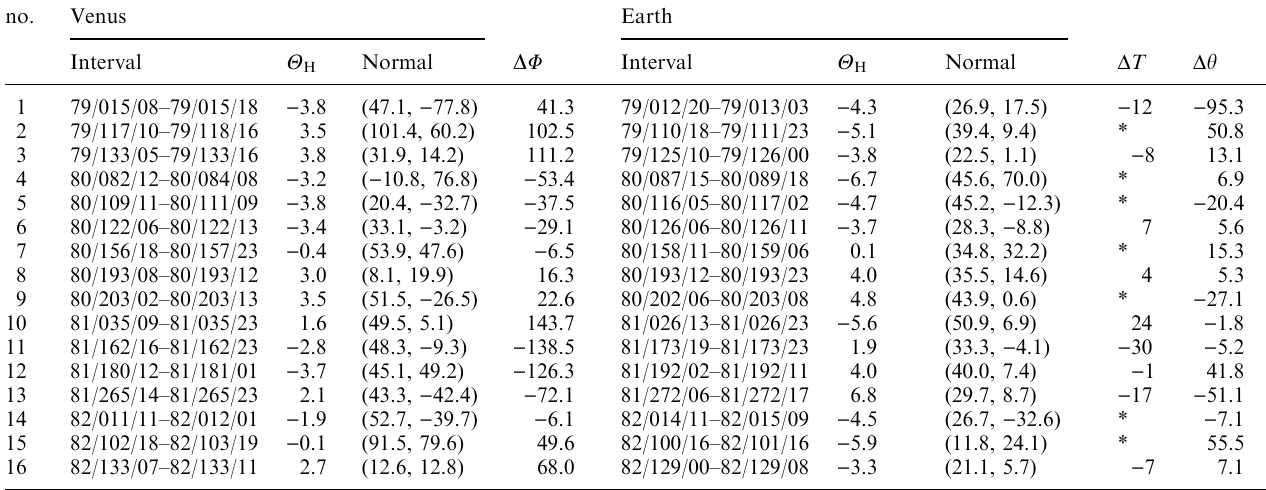
Table 1. Sector boundaries observed at Venus and Earth; * time lag is not estimated because of the small-scale structures contained within one or both sector boundaries no. Venus Earth Interval H H Normal D U Interval